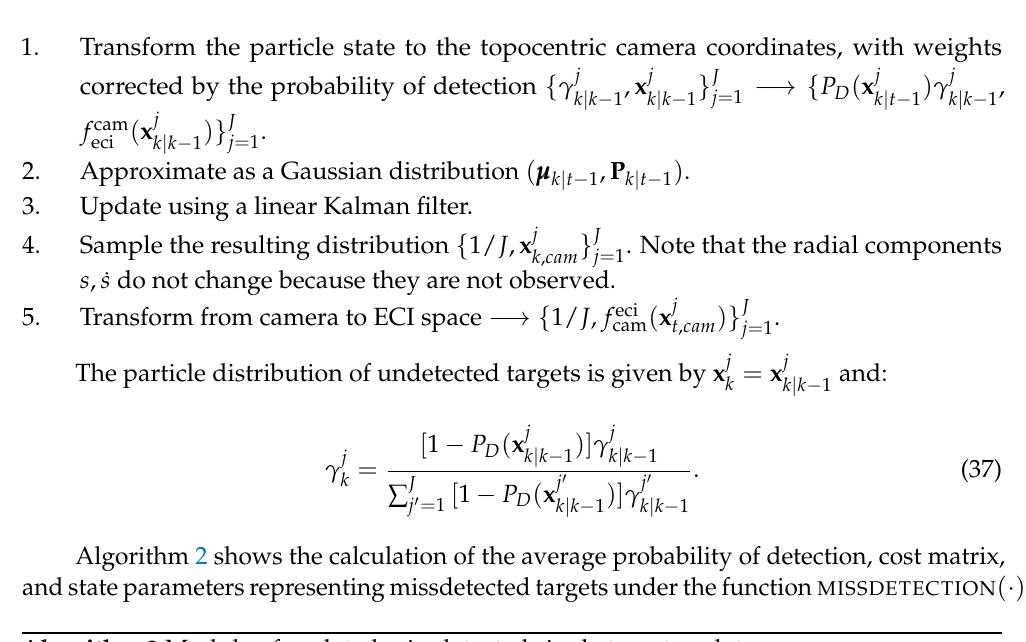
Algorithm 2 Module of updated missdetected single target